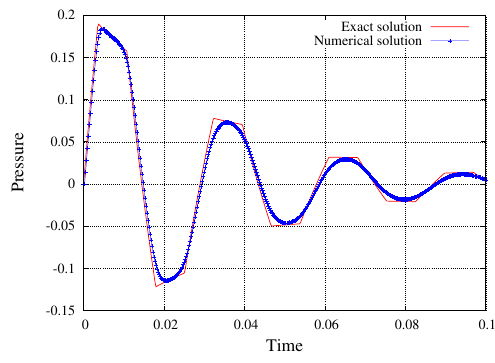
Figure 4. Time history for an accurate enough approximation of the analytical solution and a numerical solution for pressure, obtained by scheme (2.7) for the column problem with N = M = 400 at node x = 0 .